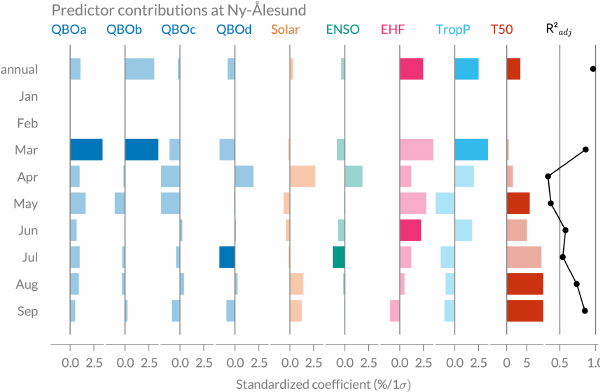
Figure B2. Same as Fig. B1 but for